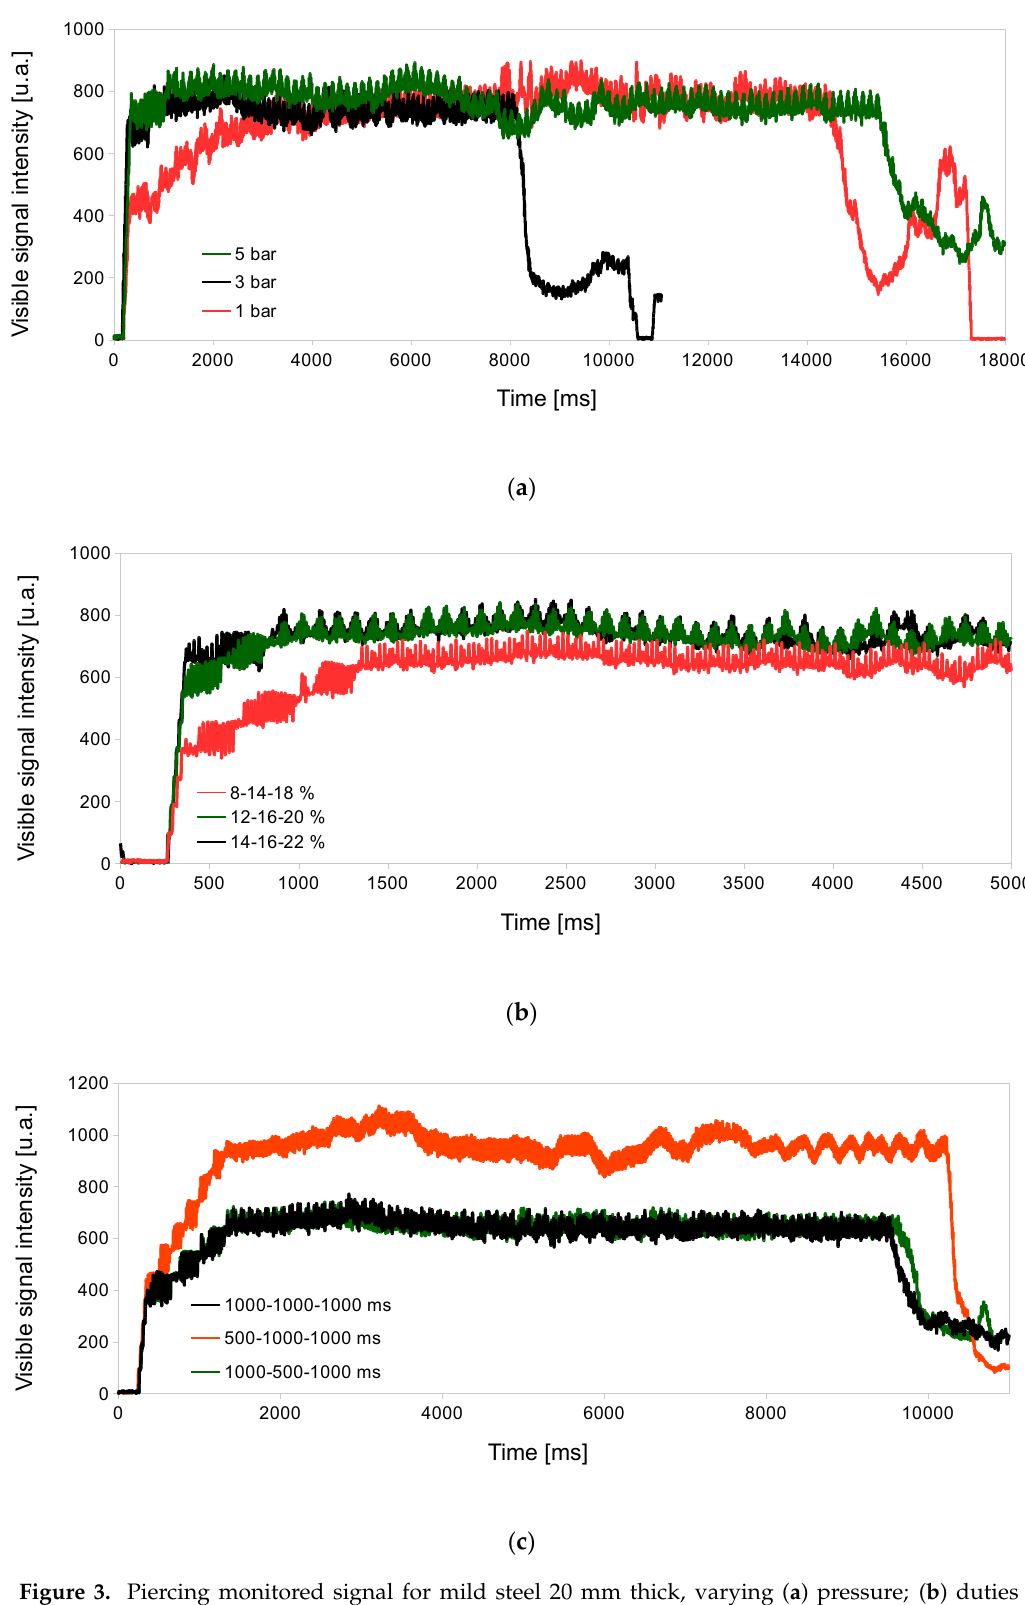
Figure 3. Piercing monitored signal for mild steel 20 mm thick, varying ( a ) pressure; ( b ) duties percentage; ( c ) ramp time.